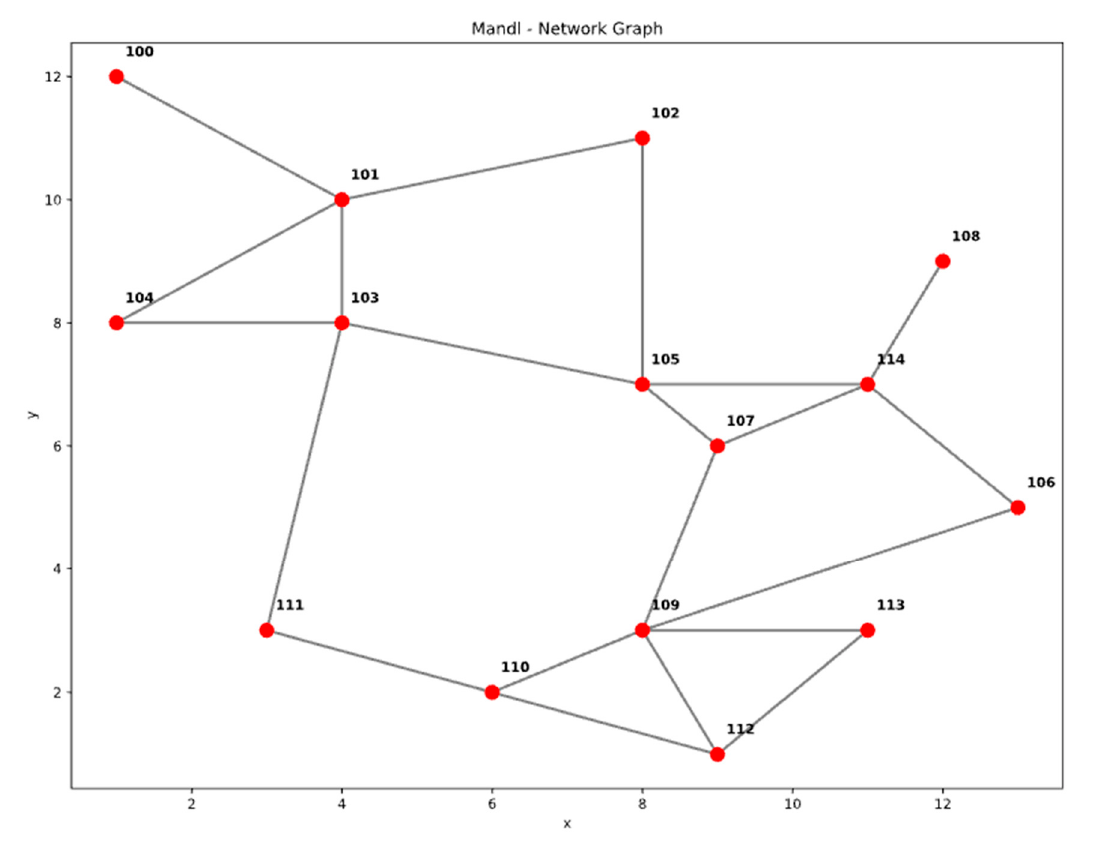
Figure 3. Mandl network graph. Table 1. Comparison of AOGAE results with similar methodologies.